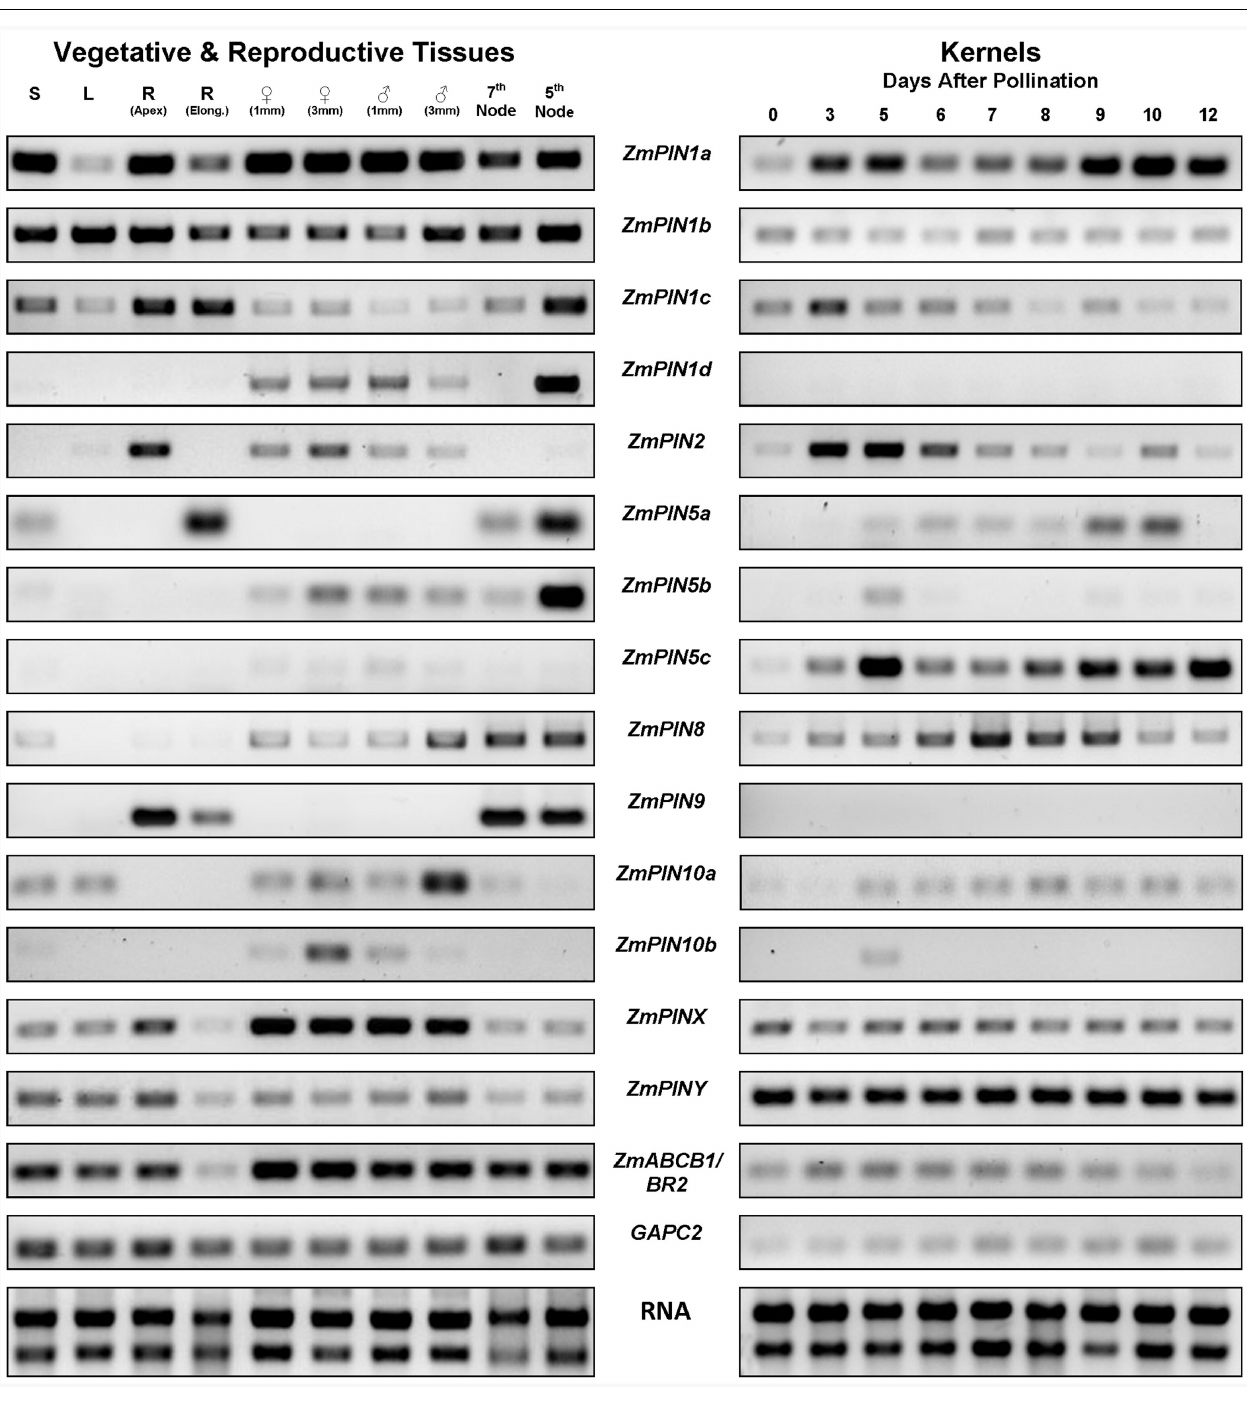
FIGURE 4 | Expression analysis of maize auxin transporters. Semi-quantitative RT-PCR analysis of 12 ZmPIN genes, two maize PIN-like genes and BR2 , a maize MDR/PGP/ABCB efflux transporter in vegetative and reproductive tissues and in kernels from 0 to 12days after pollination (DAP). The constitutively expressed GAPC2 gene was used as housekeeping internal control of the RNA/cDNA quantity.To get semi-quantitative results, the number of cycles of the PCR was adjusted for each gene to obtain barely visible bands in agarose gels (seeTable S2 in Supplementary Material for the